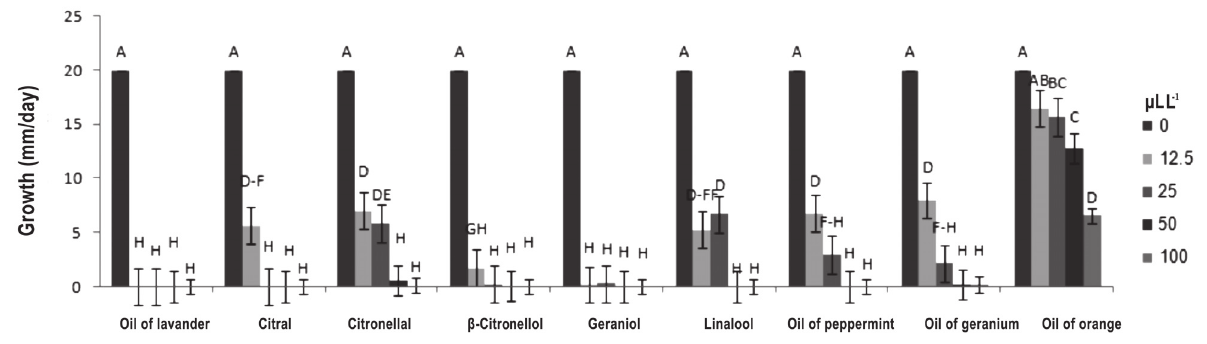
Figure 2. Mean colony growth rate (mm day -1 ) (fumigant effect) of Pythium aphanidermatum grown on agar plates amended with different essential oils. Bars followed by the same letter are not signi fi cantly different ( P ≤ 0.01%), Dun- can’s Multiple Range Test. (concentration of oil of lavender: 0, 0.25, 0.5, 1, 2 mL L -1 jar).